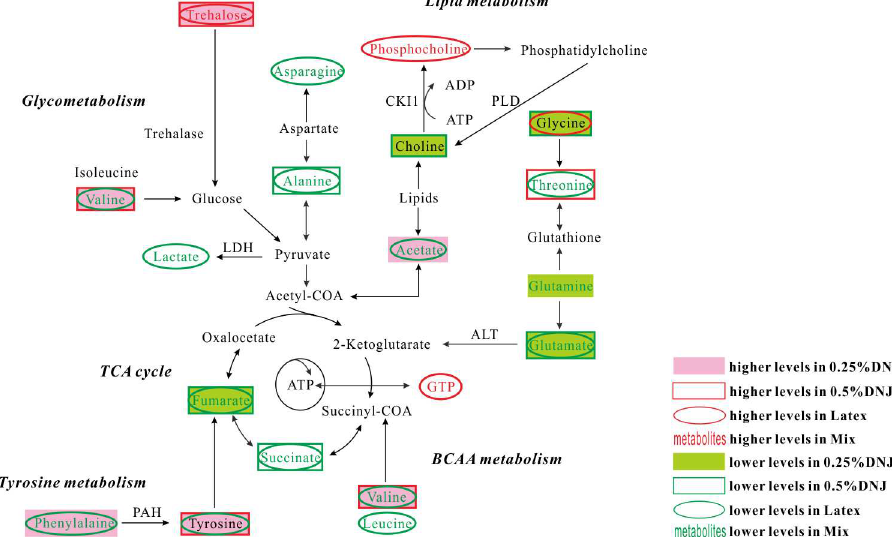
Fig 5. Schematic diagram of the metabolic pathways. The metabolitechangesdetected with 1 H NMR midgut analysis, and the pathwayreferencedto the KEGG databaseshowedthe interrelationships of the identifiedmetabolicpathways in the experimental Eri silkworms. Metabolites with increasedand decreased levels in the midgut, comparedwith those in the control group, are respectively indicatedin red and